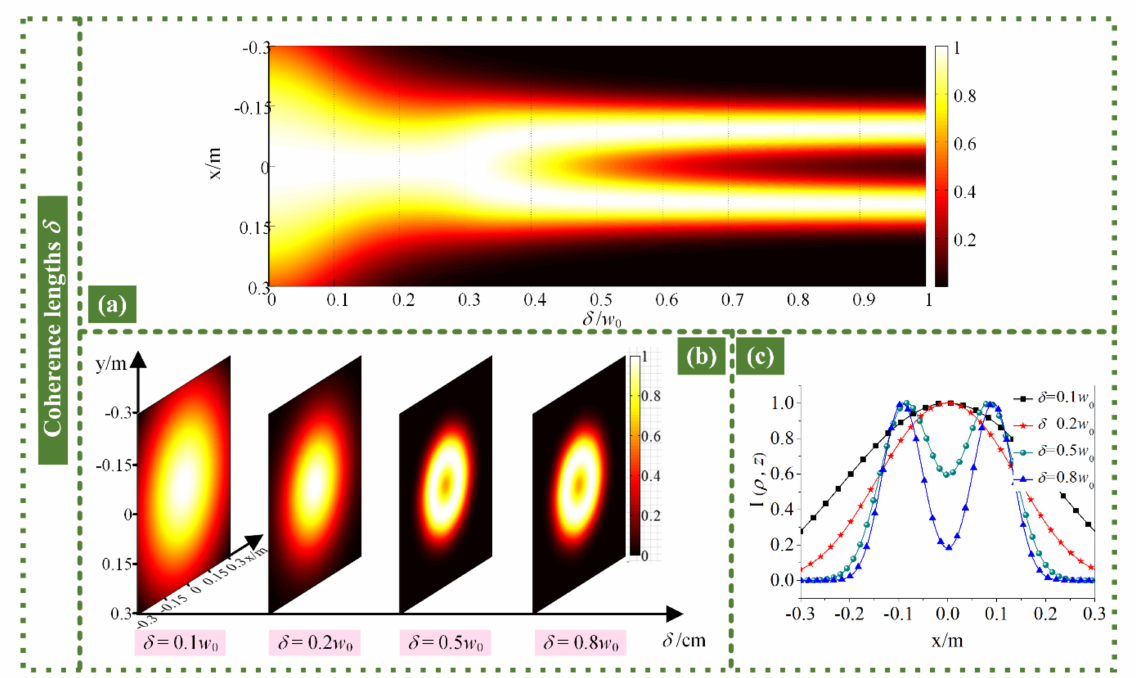
Figure 6. ( a ) Evolution of intensity distributions of RPLPCV beam array through non-Kolmogorov turbulence with coherence lengths δ ; intensity ( b ) distributions and ( c ) profiles of the RPLPCV beam array propagated through non-Kolmogorov turbulence for different coherence